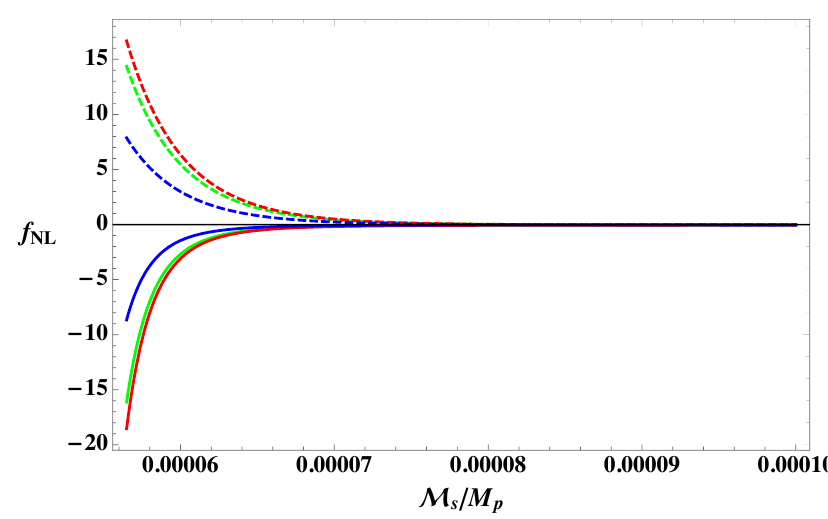
Figure 6 . In the above plots, f NL versus the scale of non-locality M s (in the units of M p ) is depicted for squeezed k 3 (cid:28) k 1 = k 2 (blue), equilateral k 1 = k 2 = k 3 (red), and orthogonal k 1 = 2 k 2 = 2 k 3 (green) con(cid:12)gurations for the entire functions (4.19) and (4.20) represented by solid and dashed lines respectively. Here N (cid:3) = 55 and (cid:12) 1 = 1 ; (cid:12) 2 = (cid:0) 2. It can be seen that in the limit M s ! M p , the predictions of the local R 2 model are